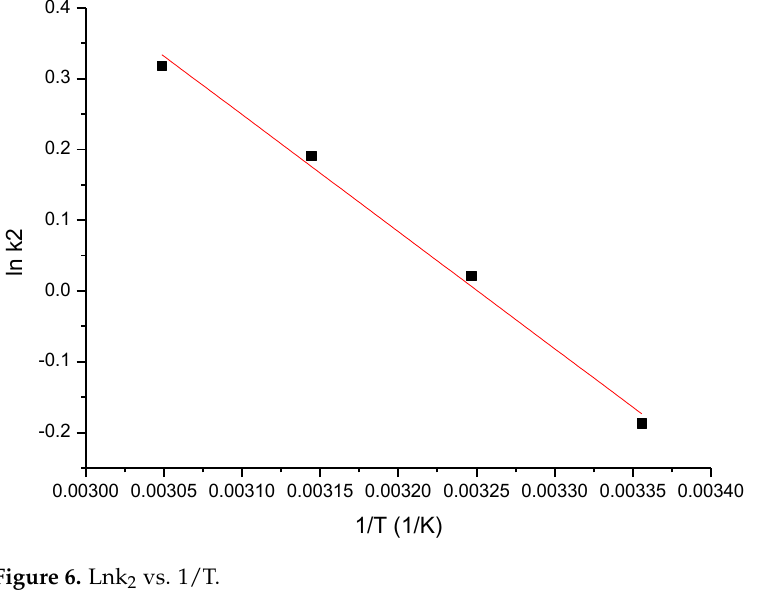
Figure 6. Lnk 2 vs. Figure 6. lnk 2 vs. 1/T.